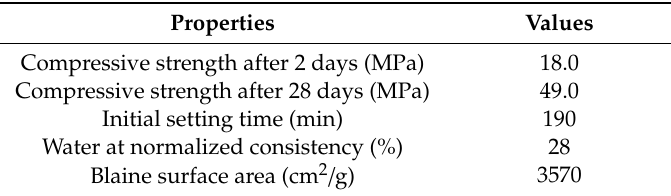
Table 3. Basic properties of CEM II / B-S 32.5 R cement.